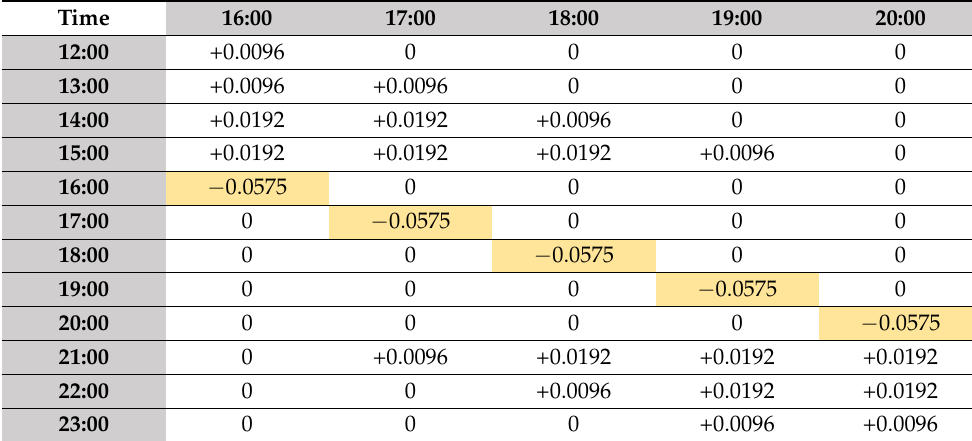
Table 11. Base self-elasticity, lossless PEMD with AC shifting scenario.